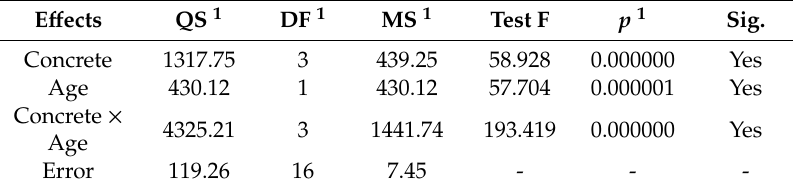
Table 6. Analysis of variance (ANOVA) of the compressive